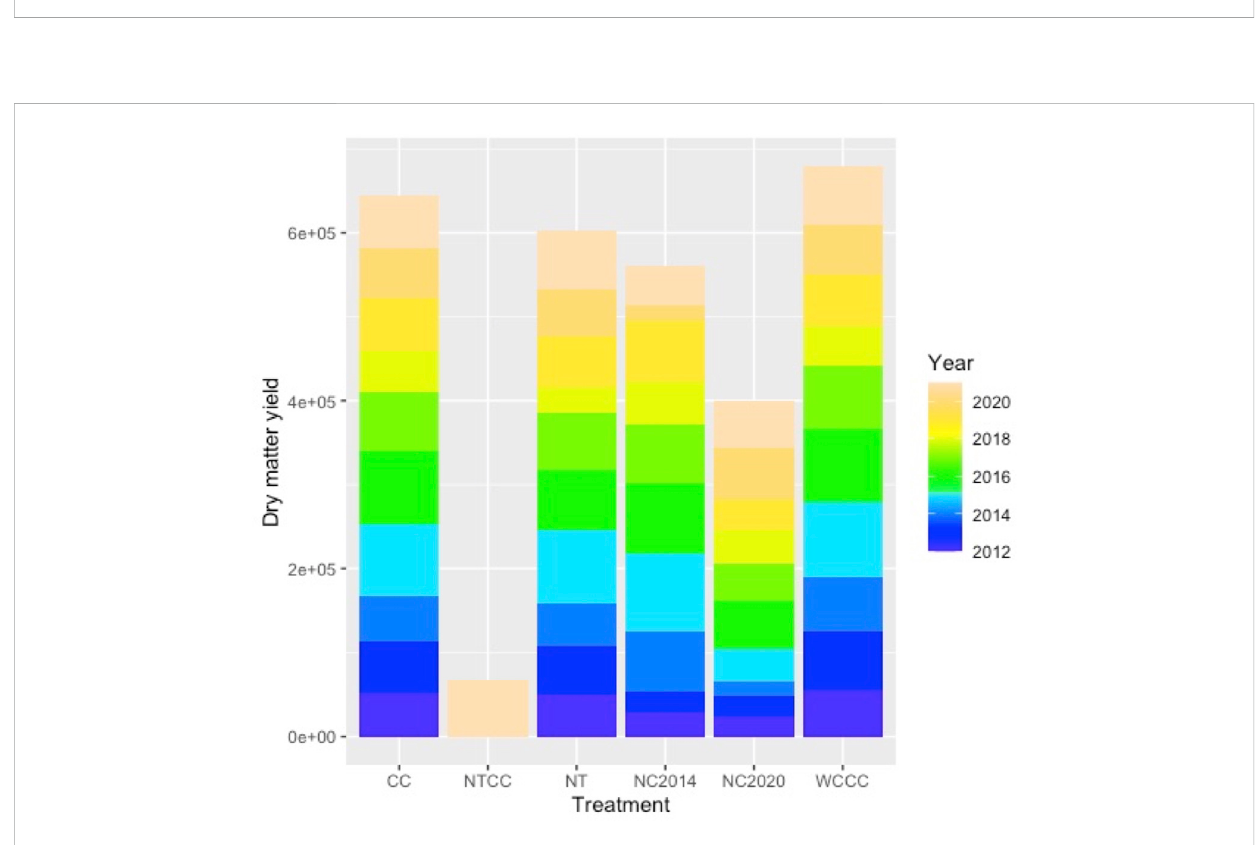
FIGURE 5 Total dry matter yields over the duration of the study by treatment, including dry matter in perennial forage and corn